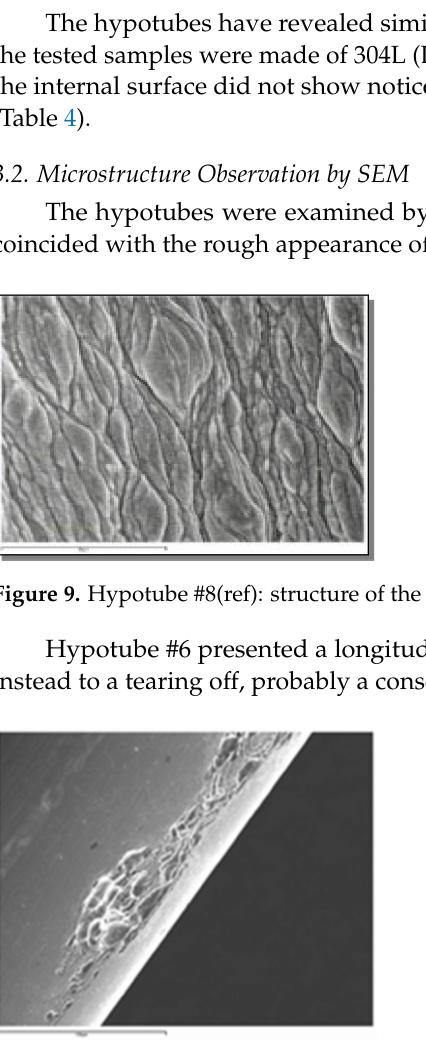
Figure 10. Longitudinal defect of hypotube #6 (scale = 200 µ